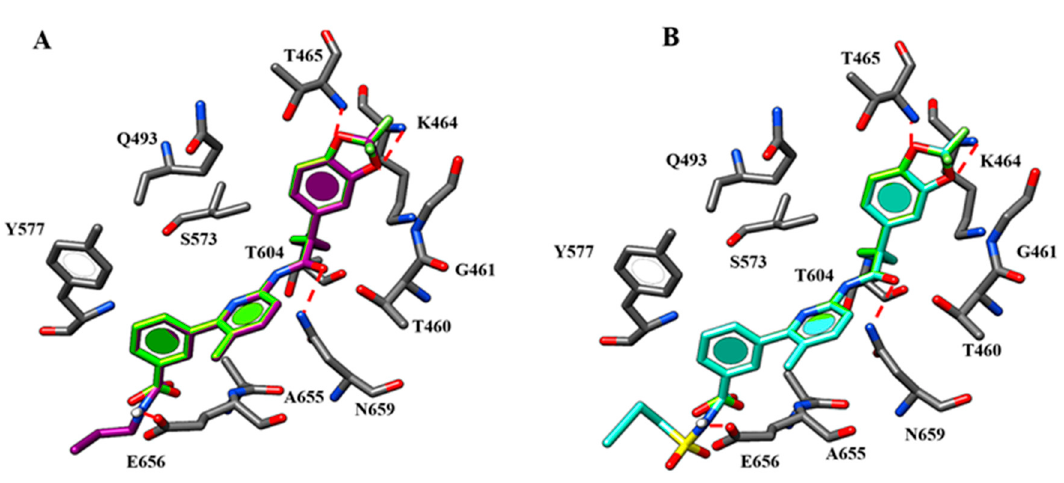
Figure 3. Selected docking poses of ALK-809 (C atom; pink) ( A ) and SUL-809 (C atom; cyan) ( B ) within the CFTR h NBD1 domain together with VX-809 (C atom; green). The most important residues are labelled.